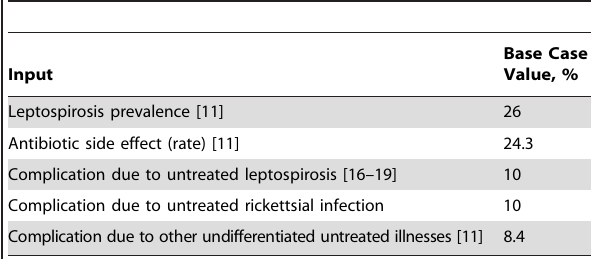
Table 1. Values and sources of inputs used in the decision model.